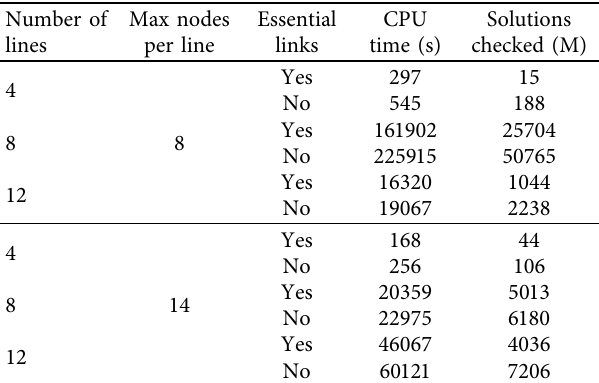
Table 8: The impact of essential links on the exact